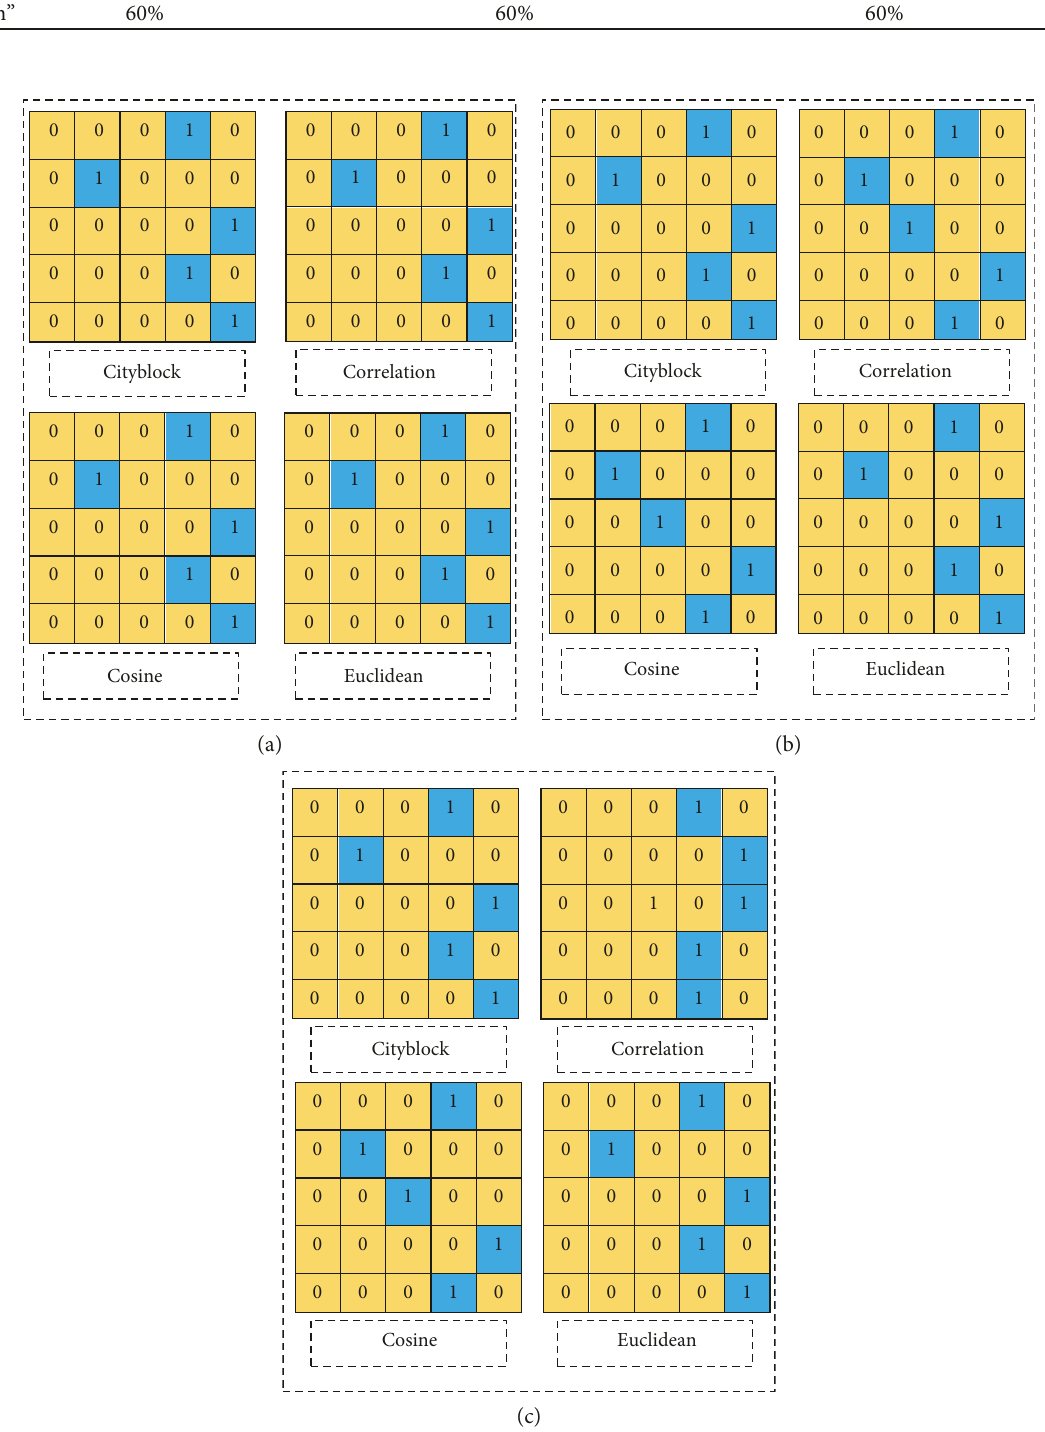
Figure 6: Presentation of confusion matrix for various k values, distance types, and classi fi cation